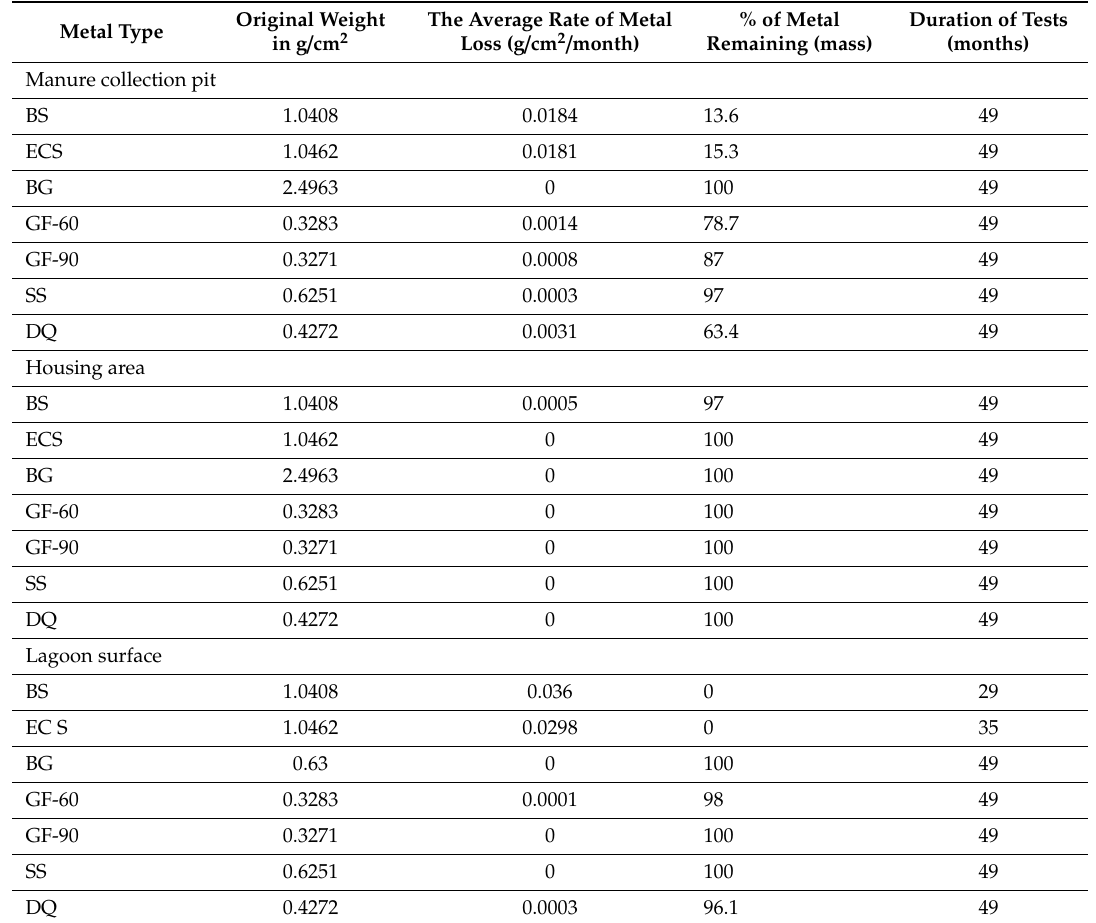
Table 1. Metal losses due to corrosion in swine manure environments [3]. “Reproduced with